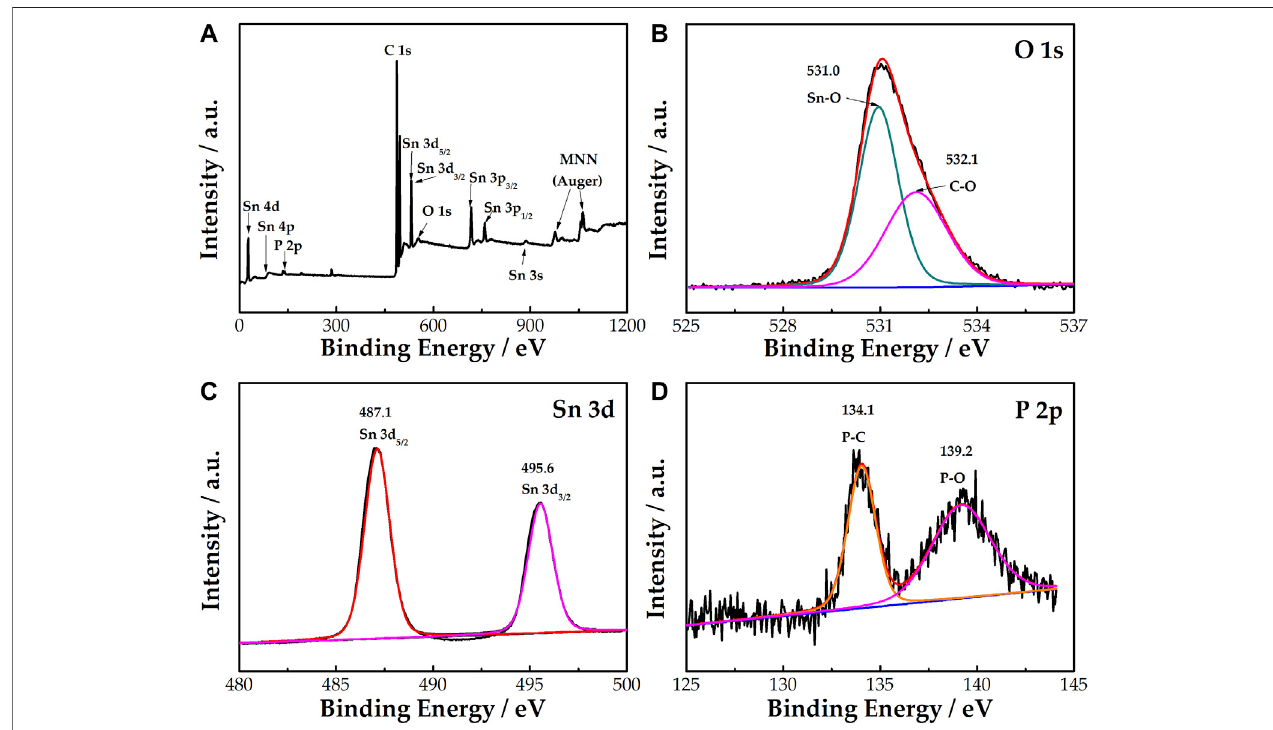
FIGURE 4 | CV curves for AB, SnO 2 , and SnO 2 -P carried out in 1.6 M V 3+ + 3.0 M H 2 SO 4 electrolyte at a scan rate of 10 mV s − 1 .